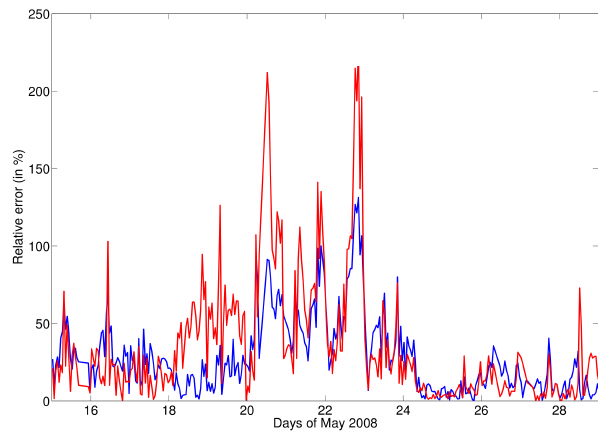
Fig. 11. Evolution of the dry mass extinction efficiency in gm − 2 at 550nm measured at Cabauw during EUCAARI and computed by the module.